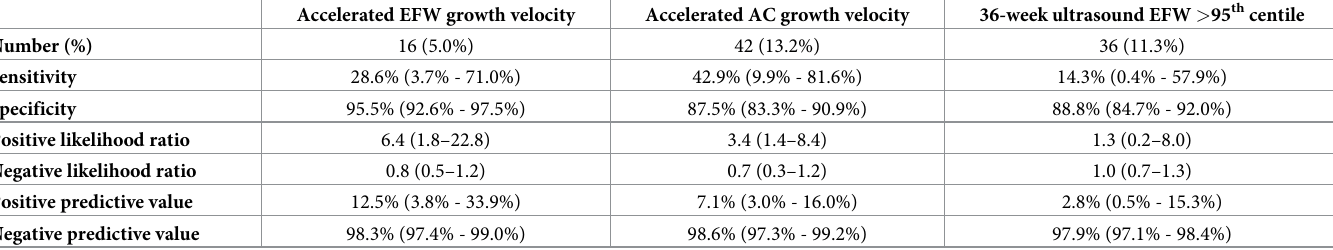
Table 4. Performance of accelerated 28–36 week fetal growth velocities ( > 30 EFW/AC centiles) and 36-week ultrasound EFW > 95 th centile in predicting shoulder dystocia among women planned for vaginal